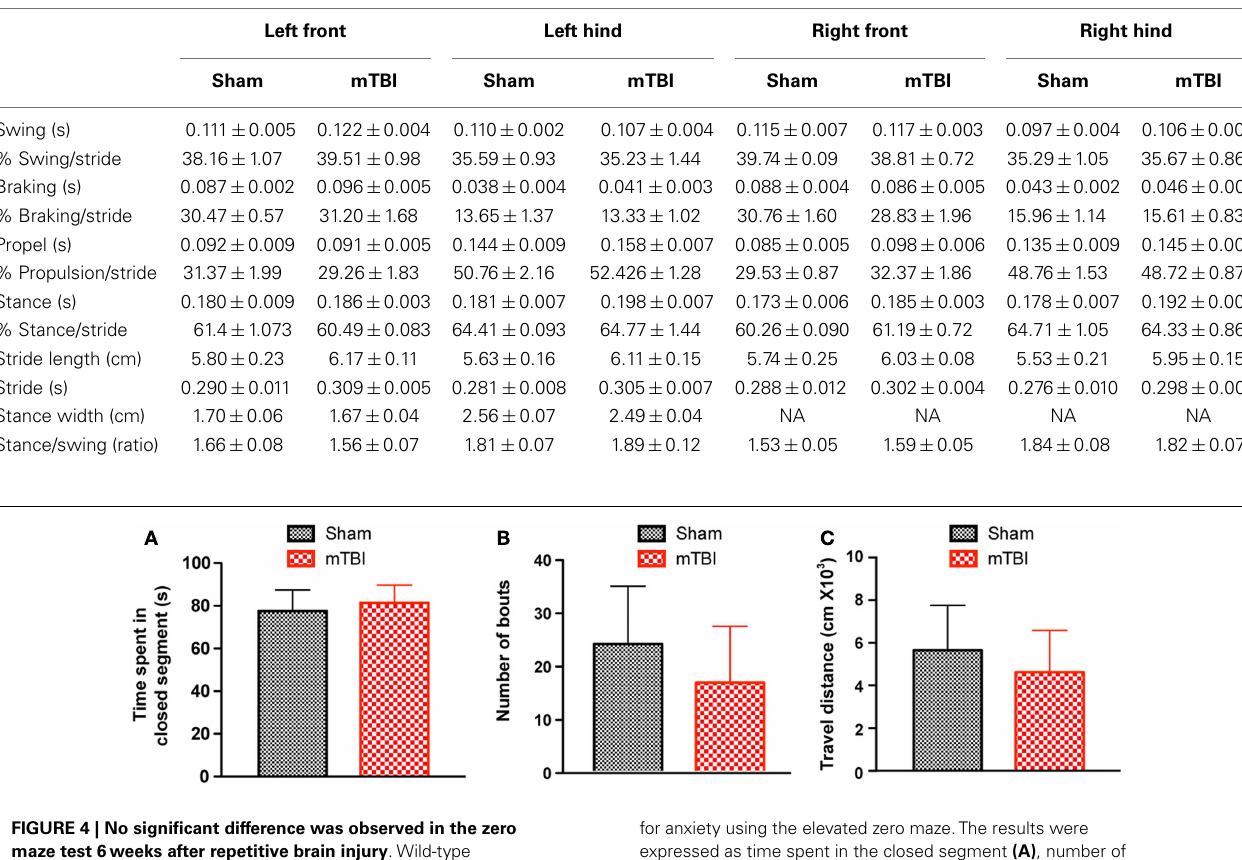
FIGURE 4 | No significant difference was observed in the zero maze test 6weeks after repetitive brain injury .Wild-type C57BL/6J mice (male, 3months of age) received three mild impacts (mTBI) or underwent sham procedures (sham), and were assessed